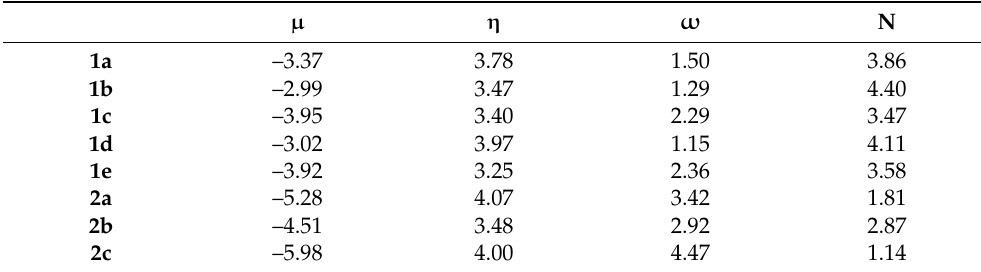
Table 1. Global electronic properties (electronic chemical potential µ , chemical hardness η , global electrophilicity ω , and nucleophilicity N; all in eV) for the studied addends.